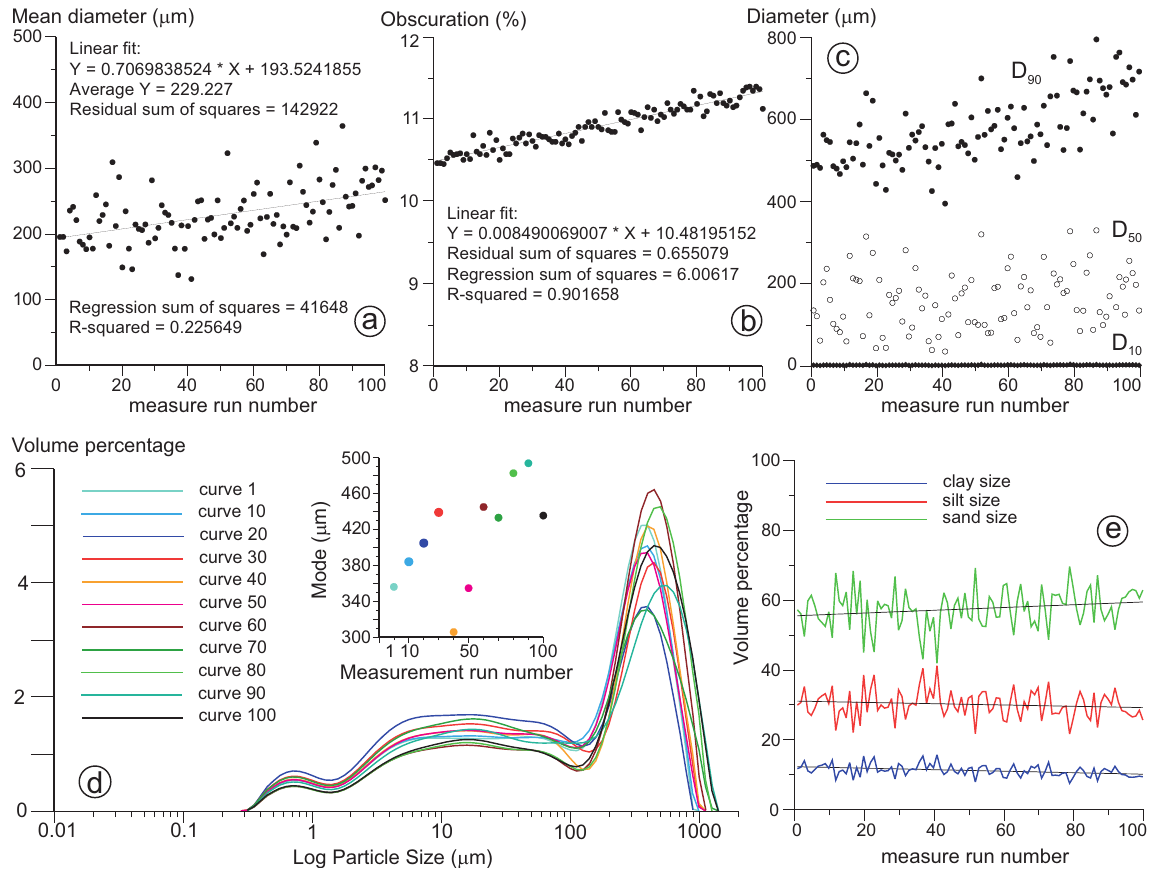
Fig. 11. Results of the measurement precision test MP2000 1 performed on sub-sample aliquot CABRE3g by the Hydro 2000 MU dispersion unit. (a) Mean diameter value evolution with increasing the number of measurement runs. Data statistics are provided. (b) Laser obscuration value progression during the same test. Data statistics are provided. (c) Progression of D 10 , D 50 , and D 90 percentiles during the same test. (d) Granulometric curves representative of the particle size evolution. The corresponding modal values (same colour code) are illustrated in the inset graph. (e) Distribution of the clay, silt and sand size fractions during the